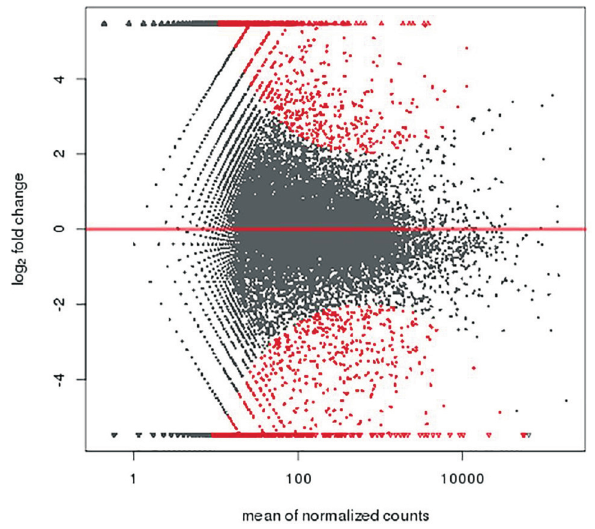
Figure 2 - A total of 1,463 genes were differentially expressed between the MR1 group and control group, among which 741 genes were found up-regulated and 722 genes were down-regulated. Abscissa: mean of nor- malized counts; Ordinate: log 2 fold change.